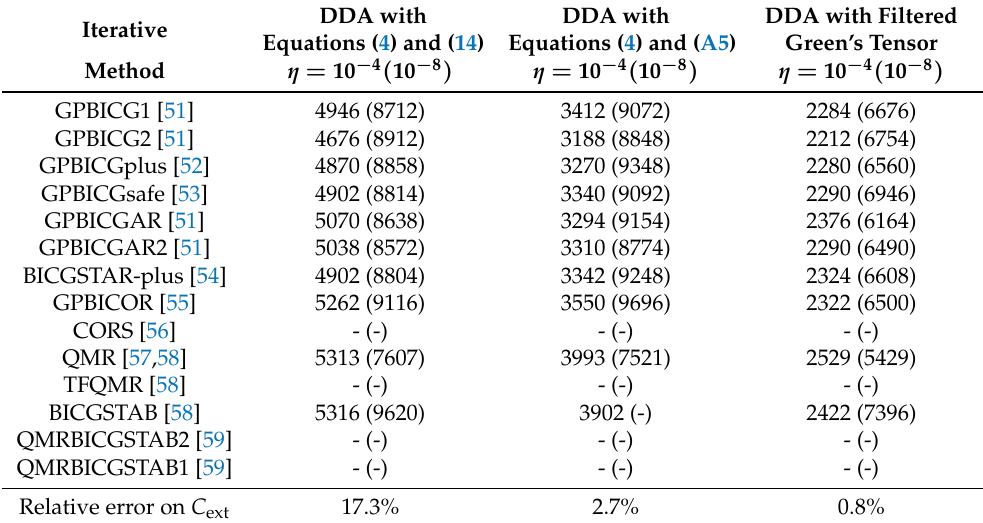
Table 2. Number of MVP for different iterative method for two values of η to solve Equation (15) and different version of the DDA. The object is a sphere of radius r = 2 λ and ε = 3. The symbol - means that the convergence of the iterative method has not been achieved. The computation are conducted with the IF-DDA code [10] and the maximum number of MVPs for iterative methods has been set at 10,000. The last line of the table presents the error in per cent on the extinction cross section, C ext , between the DDA and the Mie